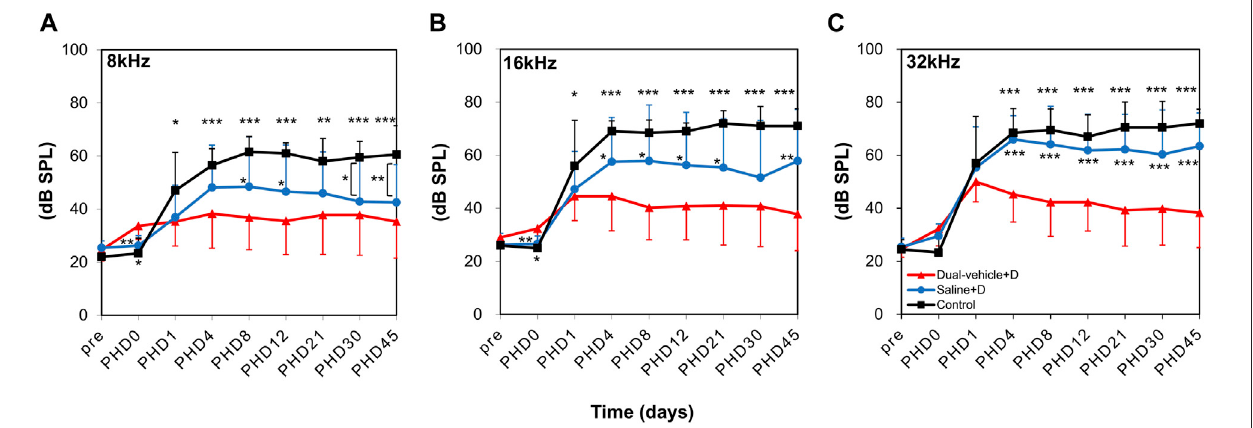
FIGURE 4 | Changes in hearing thresholds. Auditory brainstem response thresholds were measured at (A) 8, (B) 16, and (C) 32 kHz on post-hearing loss day (PHD) 1, 4, 8, 12, 21, 30, and 45. Hearing was signi fi cantly better in the dual-vehicle + D group than in the saline + D or control group from PHD 4 to the fi nal day of evaluation (PHD 45). * p < 0.05, ** p < 0.01, *** p < 0.001 compared to the dual-vehicle + D